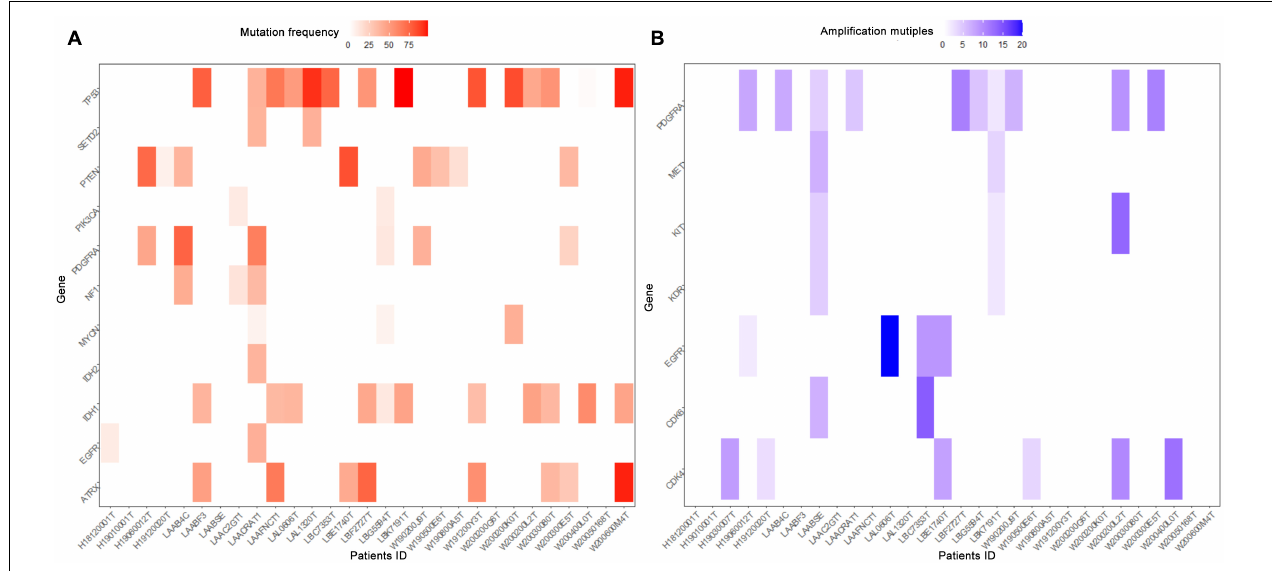
FIGURE 2 | Heatmap of molecular mutations frequencies (A) and amplification multiples (B) in ccGBM. The horizontal axis represented the identification number of tumor samples, the longitudinal axis represented related genes. Low frequencies and multiples were shown in white, high frequencies and multiples in red and blue,